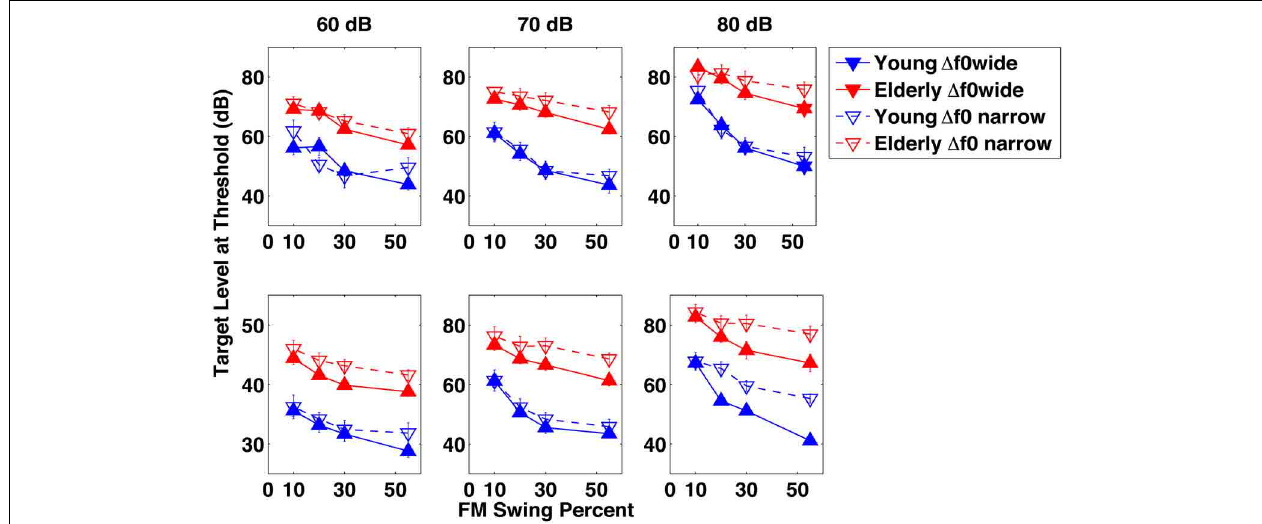
FIGURE 2 | Results of Experiment 1. Target level at identification threshold in dB as a function of the target formant’s frequency modulation swing expressed as percent maximum displacement from 1kHz, across three distracter levels in dB, in separate columns of graphs. The elderly group’s data are in red and those of the young group in blue. Filled symbols represent results for conditions in which the fundamental frequency separation (cid:2) f0/f0 between the target and